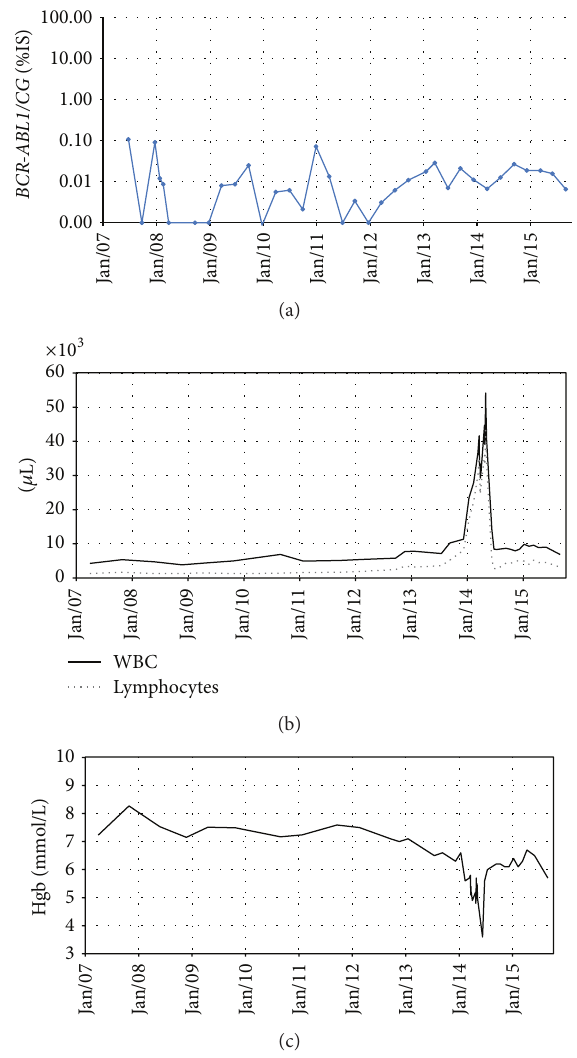
Figure 1: The results of the laboratory tests performed during the patient’s follow-up. (a) Molecular response analysis based on the BCR-ABL transcript level evaluation on International Scale. (b) Peripheral blood leukocyte (black line) and absolute lymphocytes (gray dots) count during the observation time when the patient remained in CCyR and MMR. (c) Blood hemoglobin (Hgb) con- centration during IM treatment. A significant drop in Hgb level was noted simultaneously with the rise of absolute lymphocyte blood